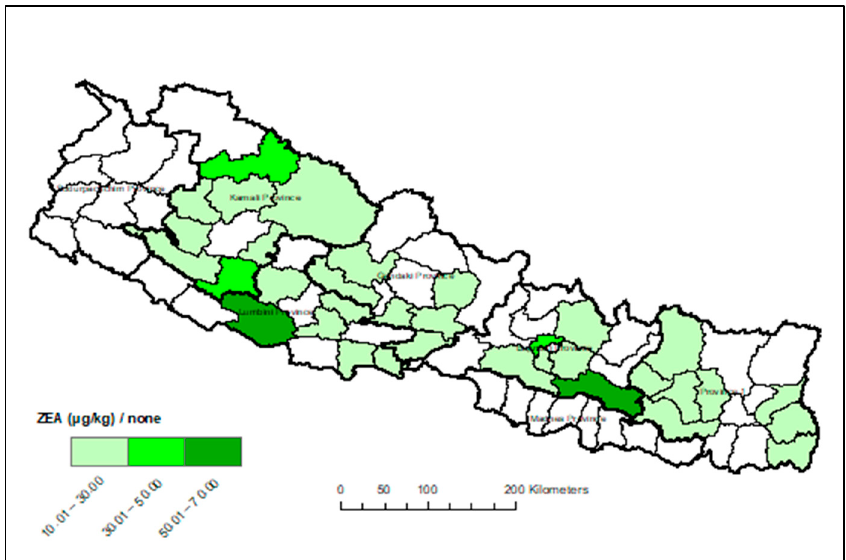
Figure A2. Heat map of ZEA occurrence in Nepalese maize. The range of found concentration of ZEA is shown in light green, green and dark green colors, representing the concentrations ranging from low to high. ZEA was found in concentrations of 11.12 to 69.52 µg/kg.